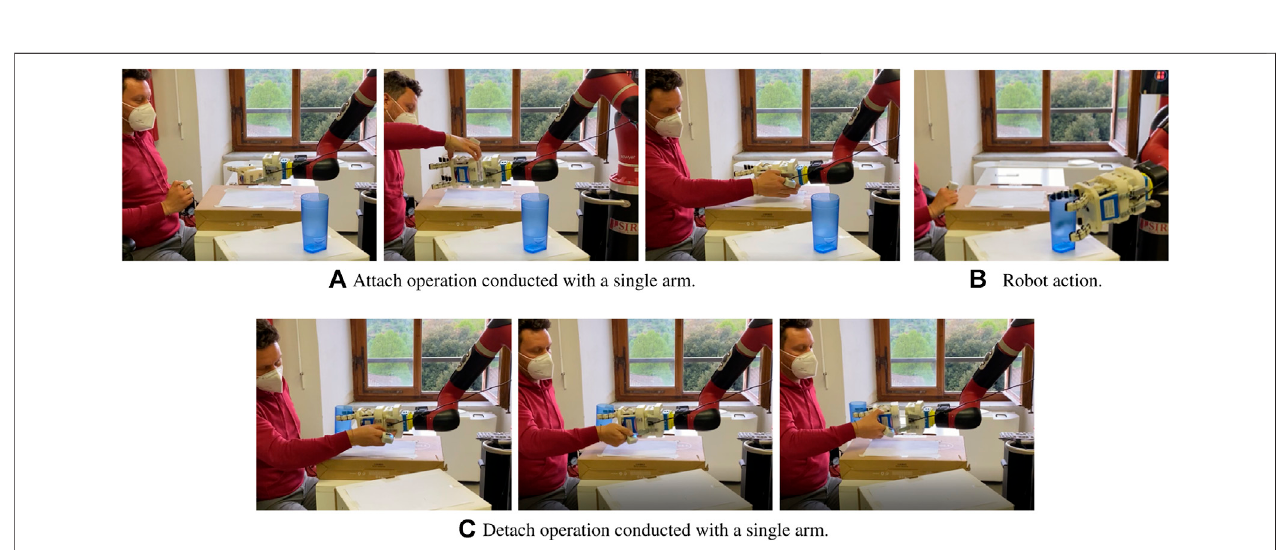
FIGURE 3 | Use of a detachable robotic gripper in an assistive scenario in which the user has lost the mobility of an arm. All the attach/detach operation can be executed with the help of the magnetic connection using only one arm.